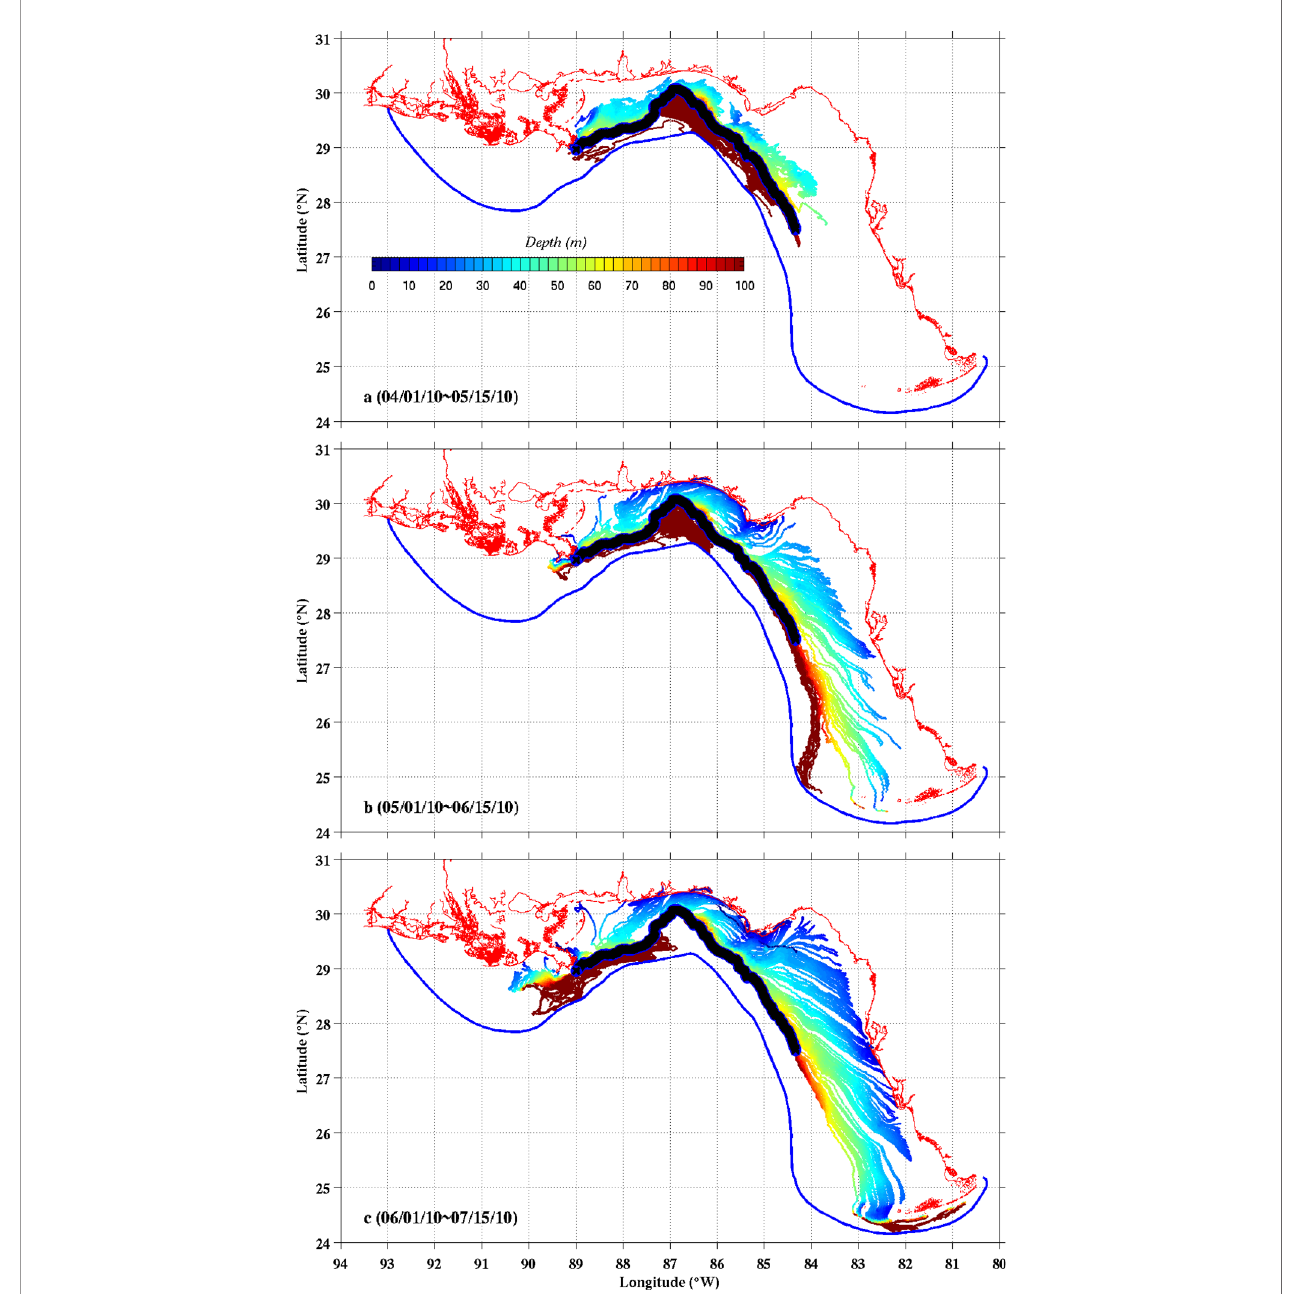
FIGURE 9 | WFCOM-simulated isopycnal water parcel trajectories, originating from the lowest model sigma layer and distributed at 1 km intervals (black dots) along the 100 m isobath. From top to bottom these span the 45-day intervals in 2010 of: (A) April 1 to May 15 (with no persistent upwelling), (B) May 1 to June 15 (with persistent upwelling occurring over the second half of the interval) and (C) June 1, to July 15 (with persistent upwelling throughout the interval), and the color-coding denotes particle depth (from Weisberg et al.,